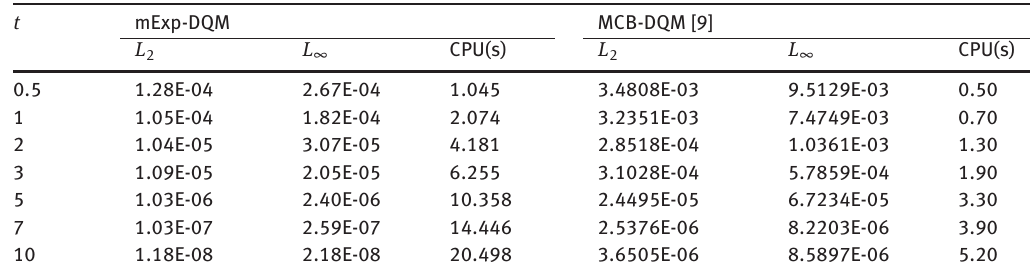
Table 5: Comparison of the mExp-DQM solutions of Example 5.2 with h = .05, (cid:2) = 0.001, α = β = 1, p = 1